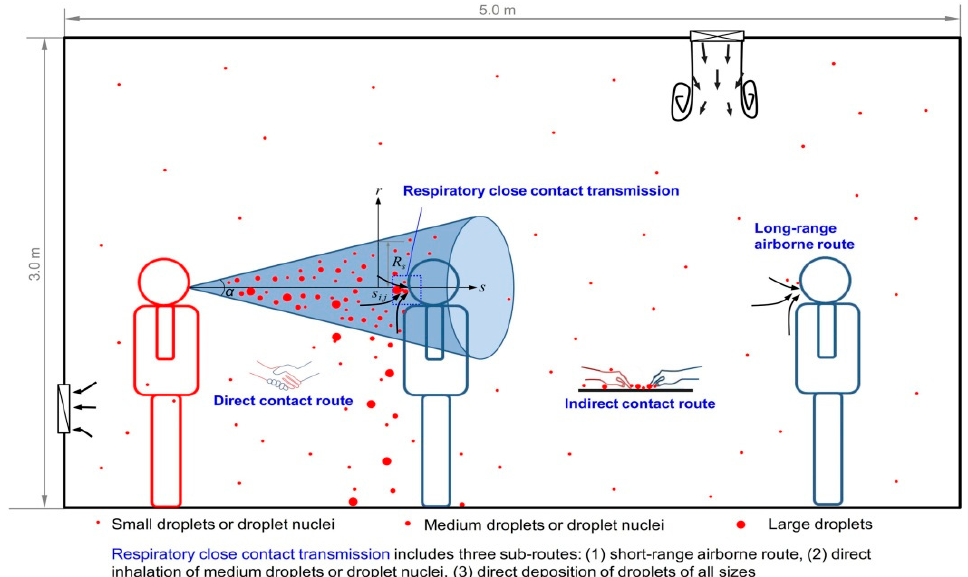
Figure 5. Illustration of the transmission of respiratory disease infection through contact with surfaces or contractions [59].